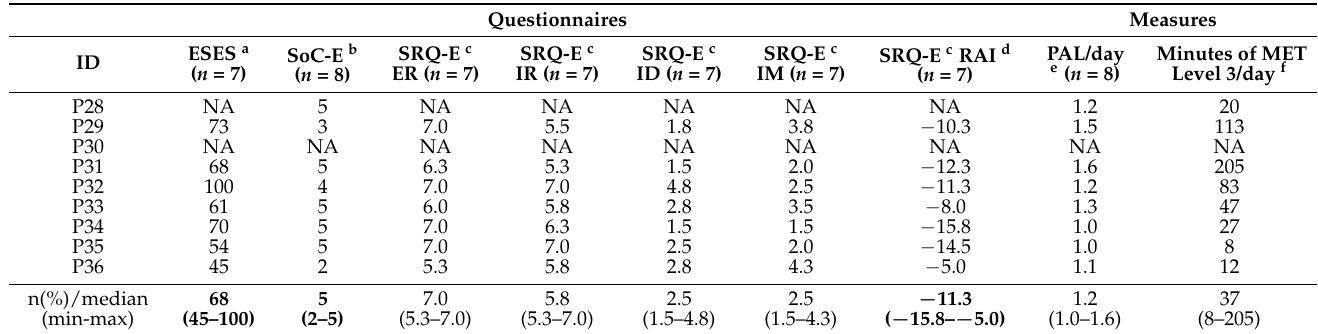
Table 1. Questionnaires, and measurements at the participant